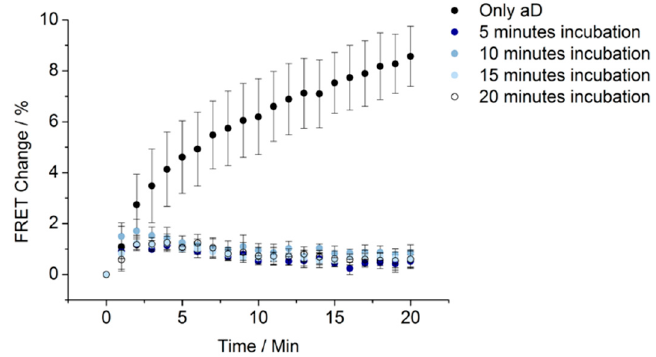
Figure 7. Influence of the incubation time of aD with digoxin for the saturation of aD. The FRET change was monitored over 20 min after adding aD (20 nM, 1 eq.) or adding aD (20 nM, 1 eq.) after saturation of aD with digoxin (200 nM, 10 eq.) for different periods of time. Experiments were performed in triplicate. The plotted values are mean values with standard deviations compared to the mean value. The FRET value at zero (0) min (only ABS) is defined as zero (0), and FRET change is calculated on this basis.